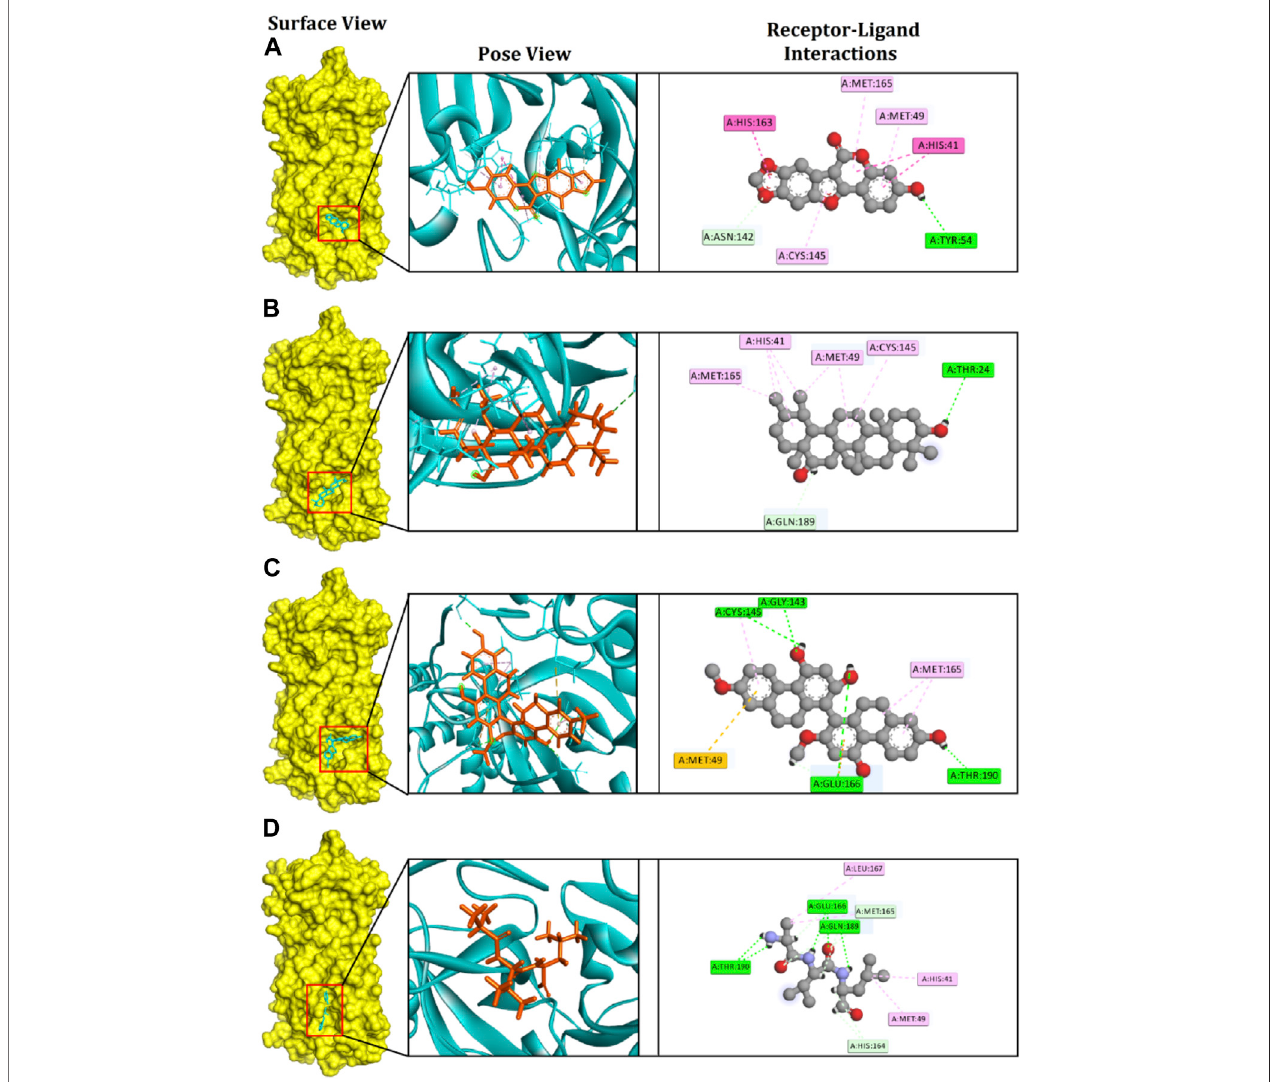
FIGURE 2 | The fi gure illustrates non-bonded interactions of the docked complexes for top three compounds within the active and catalytic sites of the main protease. (A) Medicagol, (B) Faradiol, and (C) Flavanthrin.